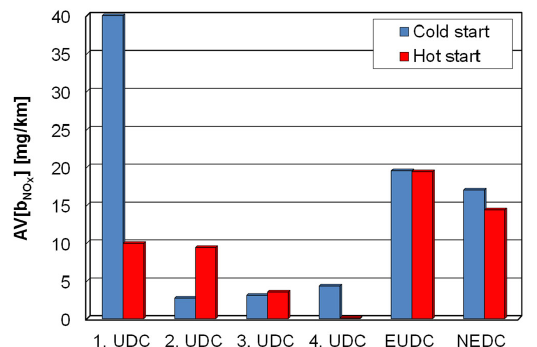
Figure 12. Average nitrogen oxides emissions (AV[b NOx ]) in four parts as well as in the NEDC test for cold and hot starts. (Figure 13). In the individual phases of the UDC test, the mean road emission value of the particle number was higher for the cold engine start, but a different relationship was observed in the case of the EUDC test and the entire NEDC test.